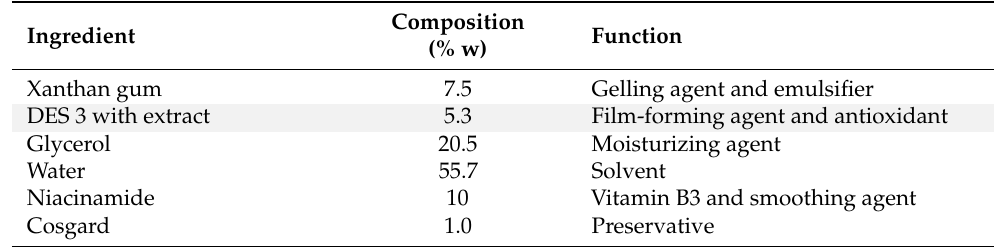
Table 11. Composition of hydrosoluble mask.